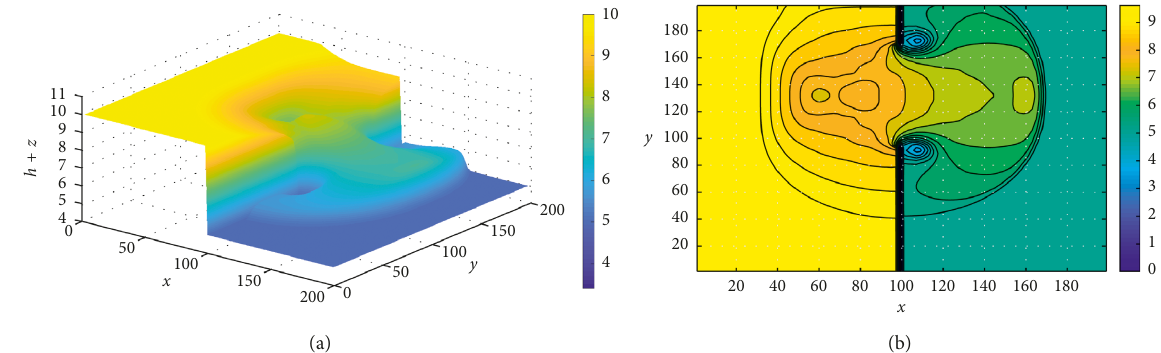
Figure 6: Water level (a) and its contour plot of h (b) of the partial dam-break problem at 7.2s.